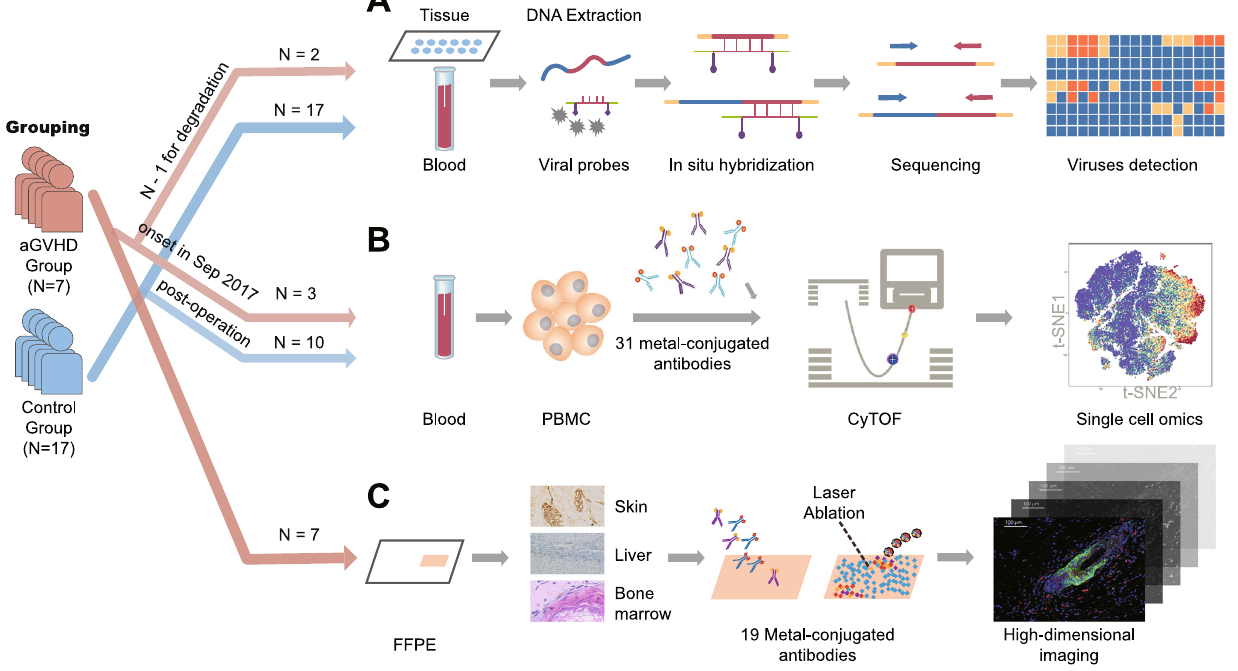
Fig. 1 | A schematic of the experimental design. A Multiple viral DNA and RNA sequences were detected in 37 specimens from the patients in the aGVHD group ( N =2) and the control group ( N =17). Tested specimens included skins with rash, peripheral blood, liver grafts, intestines, ventricular walls, and lungs. B CyTOF was performedonatotalof16samplesofperipheralbloodmononuclearcells(PBMCs)